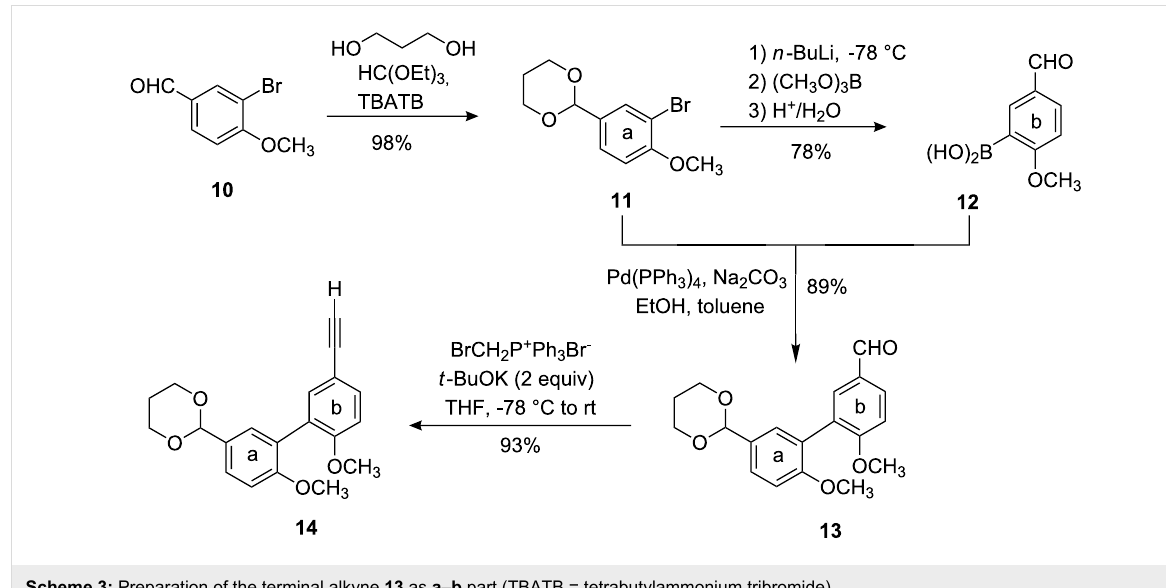
Scheme 3: Preparation of the terminal alkyne 13 as a – b part (TBATB = tetrabutylammonium tribromide).